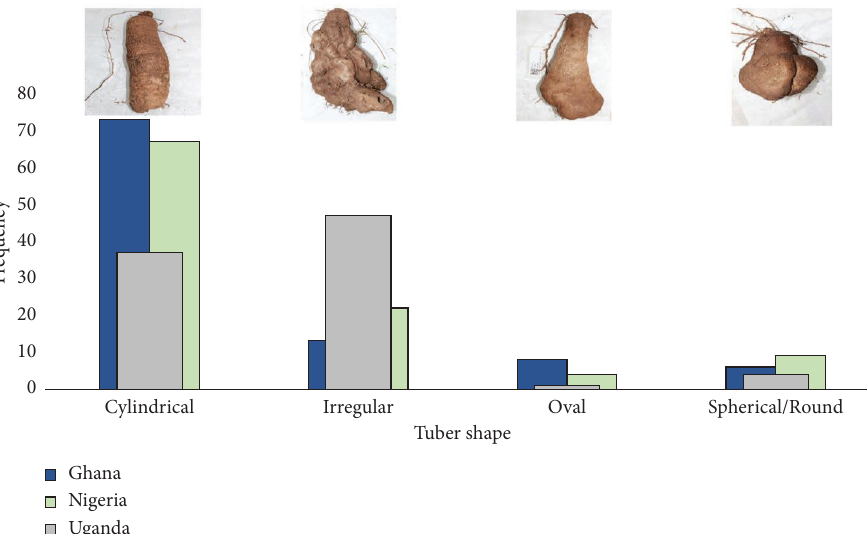
Figure 2: Phenotypic variability of plant morphology based on tuber